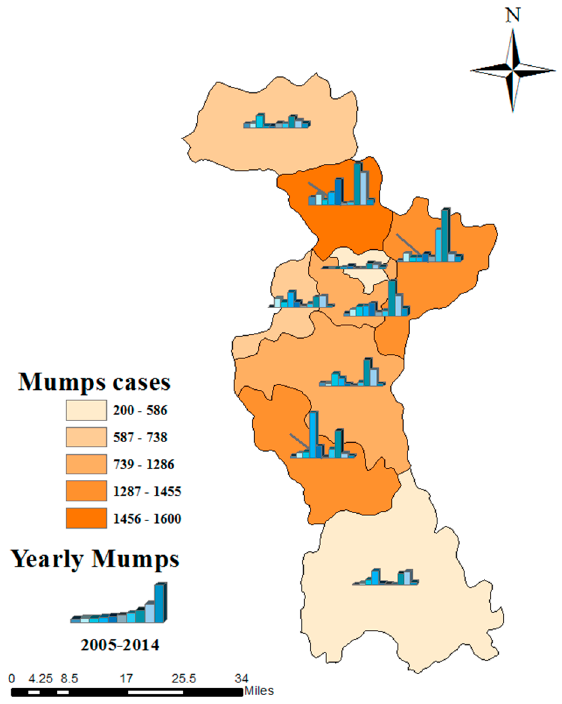
Figure 3. Geographical distribution and yearly mumps cases in Zibo City, from 2005 to 2014.